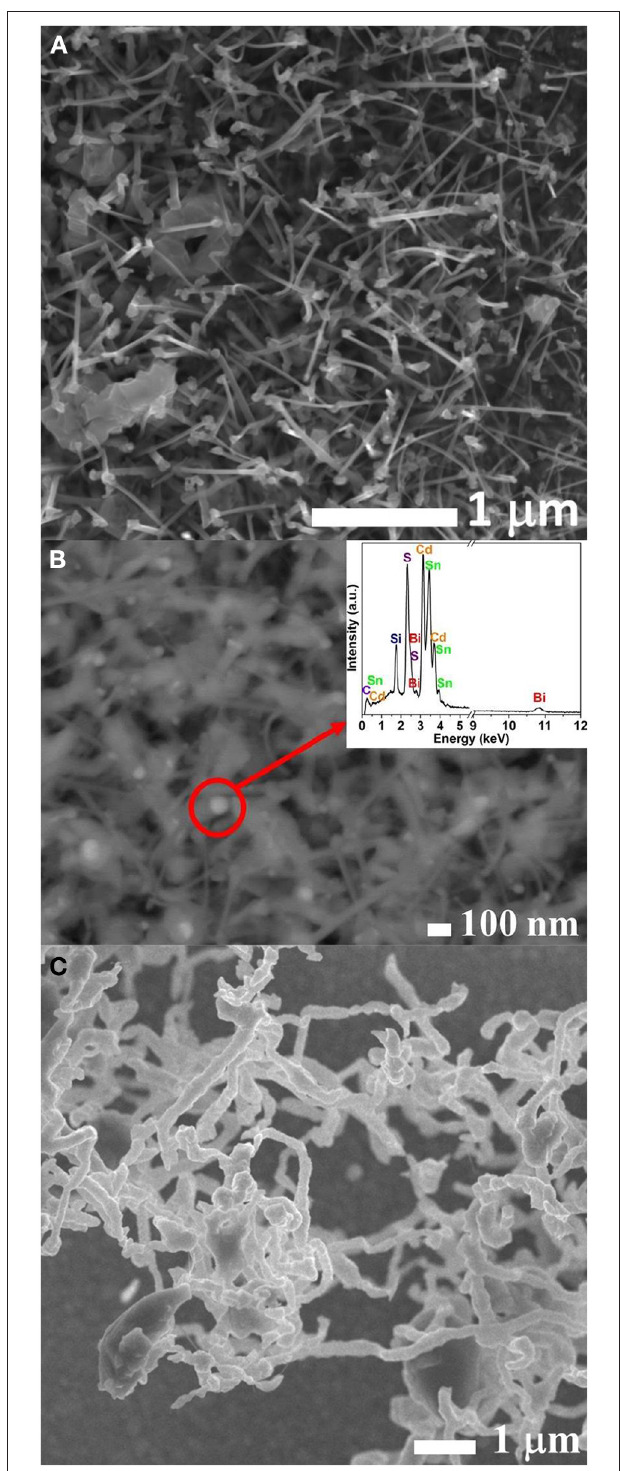
FIGURE 3 | (A) SEM images of the sample A showing a high density of CdS nanowires. (B) Backscattered electron image showing bright spots at the tip of the nanowires. In the inset, an EDS spectrum confirms the presence of Bi in the bright spots. (C) SEM images of the nanowires obtained in sample B with a substrate temperature of 270 ◦